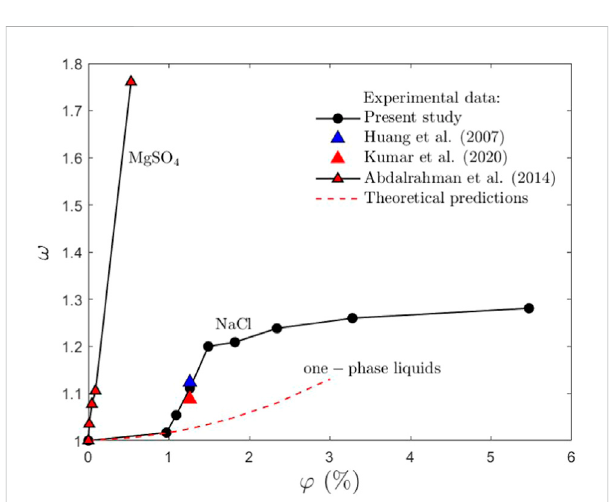
FIGURE 11 Dependenceofthedimensionless number ω ,de fi ned inEq.8)on the lubricant solution concentration φ in comparison with the experimental data for NaCl [35,36], MgSO 4 [30] and with the theoretical estimation (Eq. 9), developed for one-phase liquids. The corresponding datasets are in the Electronic Supplementary Material